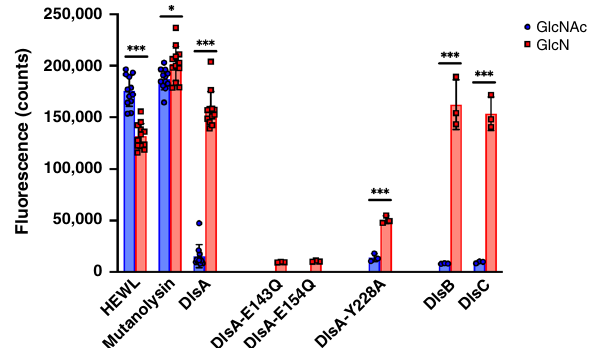
Fig. 4 Enzyme assay of DslA, related enzymes, and general lysozymes. Enzymes were incubated with acetylated peptidoglycan (GlcNAc, blue) and peptidoglycan partly deacetylated via treatment with Bdellovibrio Bd0468 and Bd3279 (GlcN, red). Fluorescence reading monitors the hydrolytic release of FITC-labeled peptidoglycan fragments into solution. Left grouping: comparison of speci fi city of DslA, hen egg-white lysozyme (HEWL), and Streptomyces globisporus mutanolysin. The non-speci fi c mutanolysin hydrolyzes both acetylated- and deacetylated peptidoglycan equally, but HEWL is speci fi c for the acetylated form (with residual activity on GlcN sample indicative of mixed material, partial N -deacetylation 15 ). DslA displays strong activity for the deacetylated GlcN sample and is unable to turnover acetylated GlcNAc peptidoglycan. Middle grouping: relative low activity of DslA putative catalytic E to Q mutants, and reduced activity for Y228A variant. Right grouping: homologous DslB and DslC proteins display a similar preference for a deacetylated substrate. Signi fi cance analysis uses two-tailed t -test, *** p < 0.0005, * p < 0.05. n = 12 independent samples for HEWL, Mutanolysin, and DlsA experiments. n = 3 independent samples for DlsA mutants and homologs (DlsB and DlsC) experiments. Data are represented as the mean ± standard